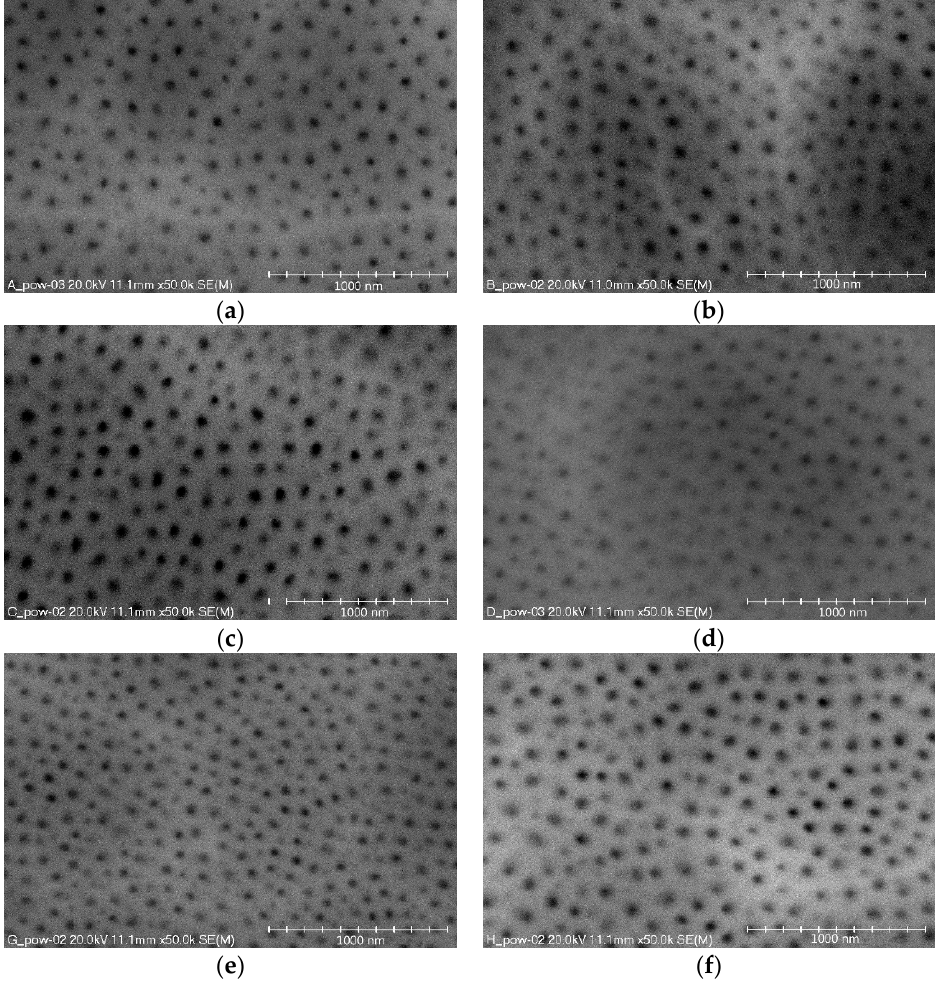
Figure 4. SEM image of nanopores in oxide layers (designations of samples in Table 1).